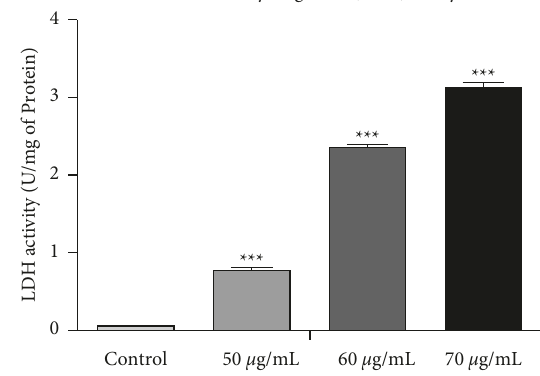
Figure 14: LDH assay in A549cell line after treatment of various concentrations of